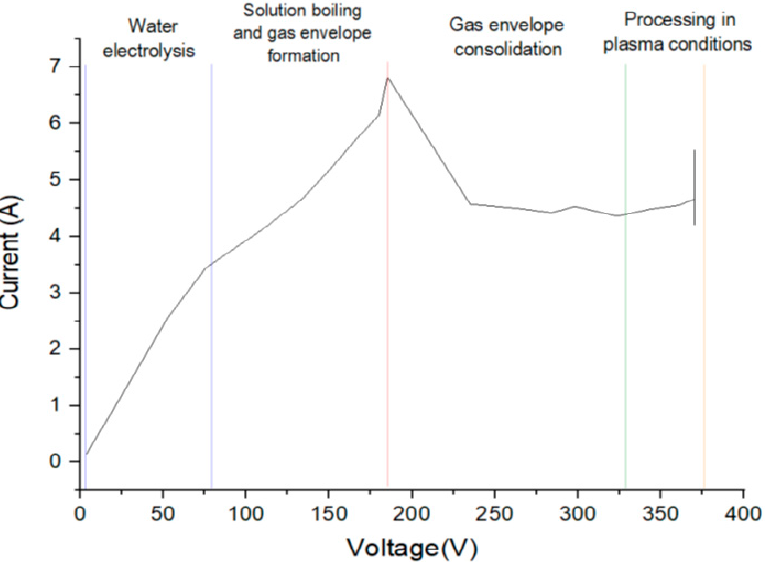
Figure 11. Current/voltage behavior during the SSONPE nitriding process of AISI 304 SS using aqueous solutions of urea and NH 4 NO 3 .